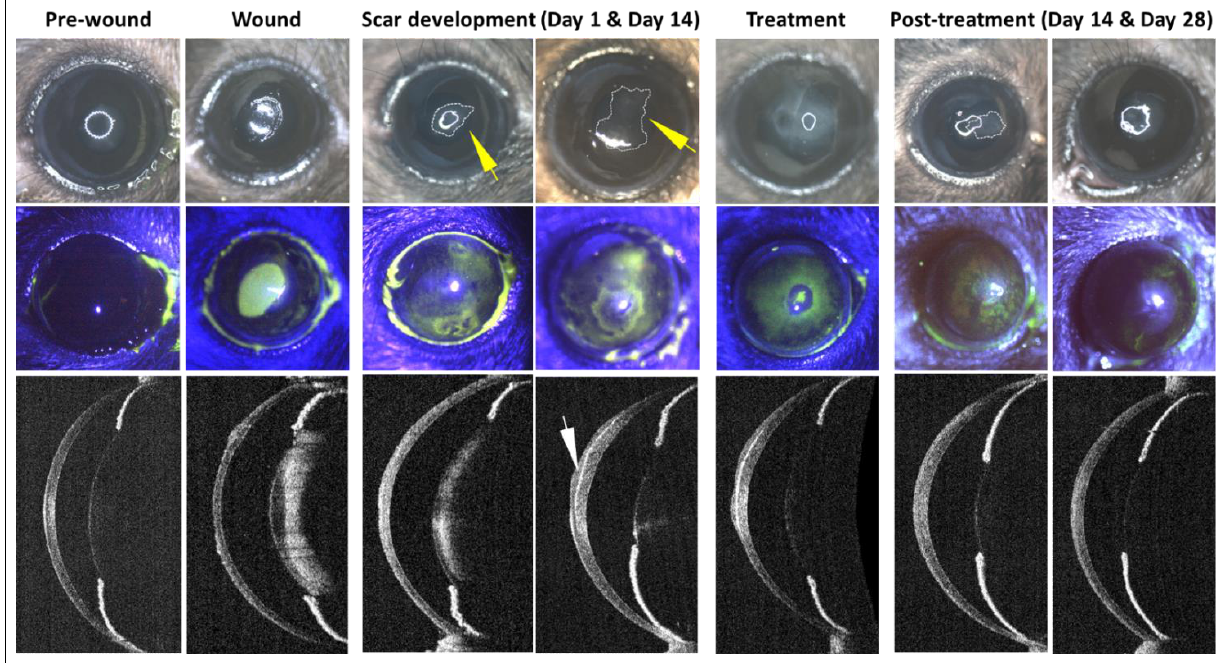
Figure 3. Generation of the corneal scar, treatment, and clinical follow-up. Collage of the representative ( scar group) clinical photographs (top row) of the normal corneal surface (pre-wound) before debriding the central cornea (wound), and the respective fluorescein staining images confirming the compromised epithelial integrity (middle row). The debrided corneas developed clouding or haze (marked with a dotted line, indicated with a yellow arrow) on day 1 after the debridement and by the end of two weeks, the debrided area developed a scar. The respective OCT scan on the lower panel shows the scarring in the anterior stroma (indicated by a white arrow) and altered corneal thickness. The scarred tissue was scraped away and treated with hLMSCs (treatment) in fibrin glue. The OCT scan on day 28 post-treatment shows stabilized corneal transparency relative to the scarred sections.